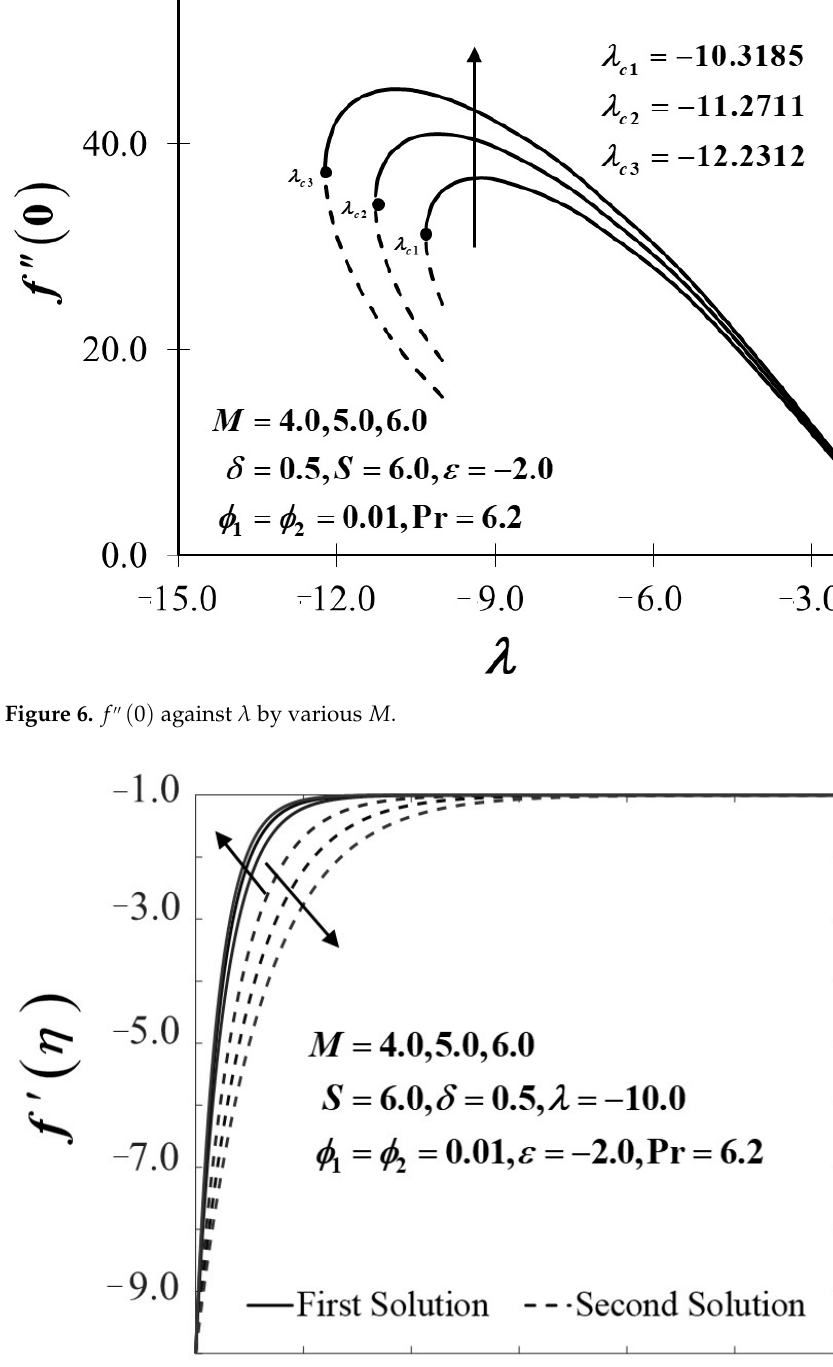
( ) Figure 7. f (cid:48) ( η ) with various M when λ = − f η ′ with various M when 10.0 λ= − . Figure 7.